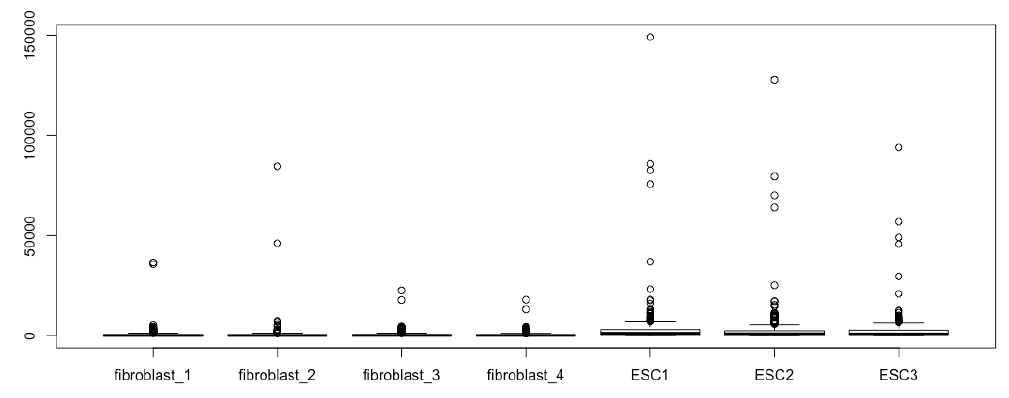
Figure 2. Boxplots prepared using the raw RNA-seq data, which cannot reveal the differential